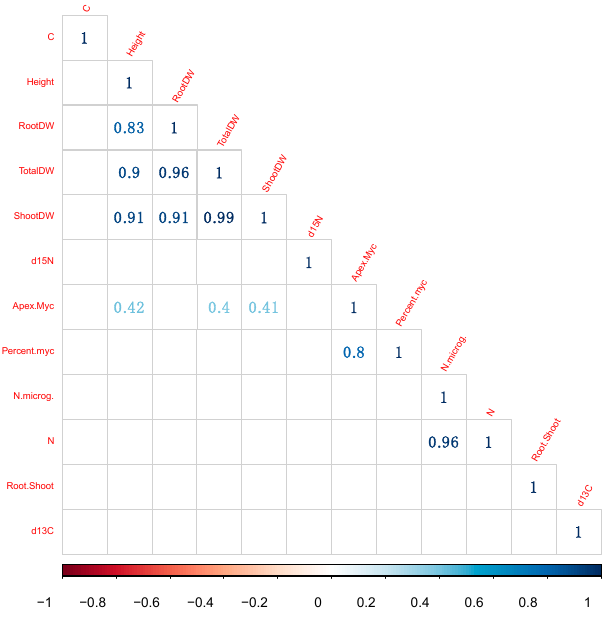
Figure 6. Significant correlations between variables, after Bonferroni corrections for multiple comparisons. N. microg: N content ( μ g).